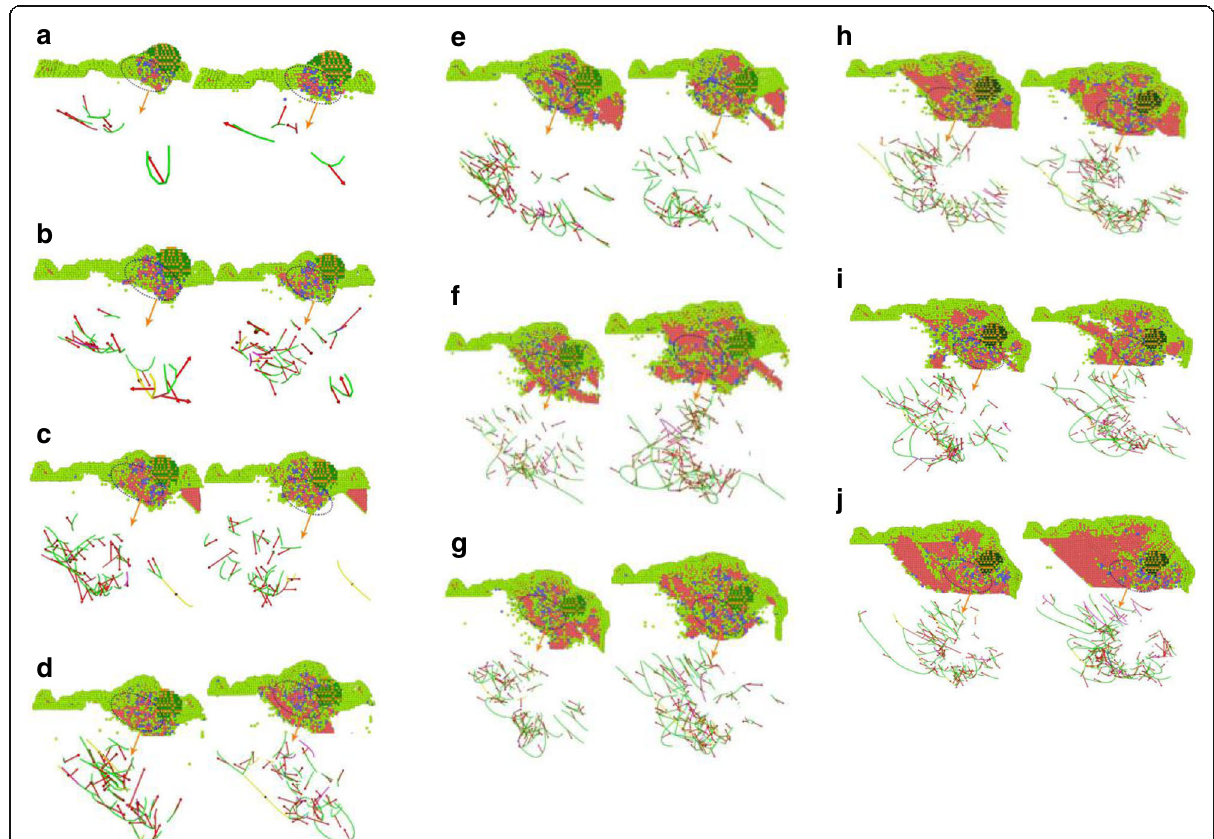
Fig. 11 Different angles-bond angle dislocation line charts. Figure 11 represents the cutting dislocation line and the bond angle. As the repeated cuttings on the workpiece surface are done by the numerous abrasive particles during the polishing process, in the entire cutting process, the abrasive particles with larger cutting angle produce bigger pits, while the following abrasive particles with smaller cutting angles continue to polish along the cutting trace. Therefore, certain depth is done on the workpiece material and the whole micro-cutting of abrasive flow polishing is achieved. a Disloca- tion lines with 0° cutting angles. b Dislocation lines with 5° cutting angles. c Dislocation lines with 10° cutting angles. d Dislocation lines with 15° cutting angles. e Dislocation lines with 20° cutting angles. f Dislocation lines with 25° cutting angles. g Dislocation lines with 30° cutting angles. h Dislocation lines with 35° cutting angles. i Dislocation lines with 40° cutting angles. j Dislocation lines with 45° cutting angles. (Note: the upper part of the key angle analysis, the figure in the atomic color: HCP BCC Amorphous structure Abrasive grain; the lower part of the dislocation line diagram, the figure dislocation line color: